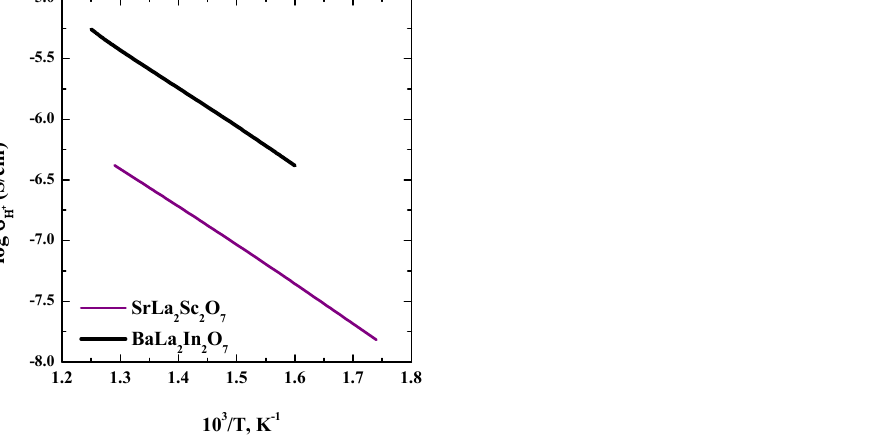
Figure 7. Temperature dependencies of protonic conductivity for SrLa 2 Sc 2 O 7 and BaLa 2 In 2 O 7 composition.